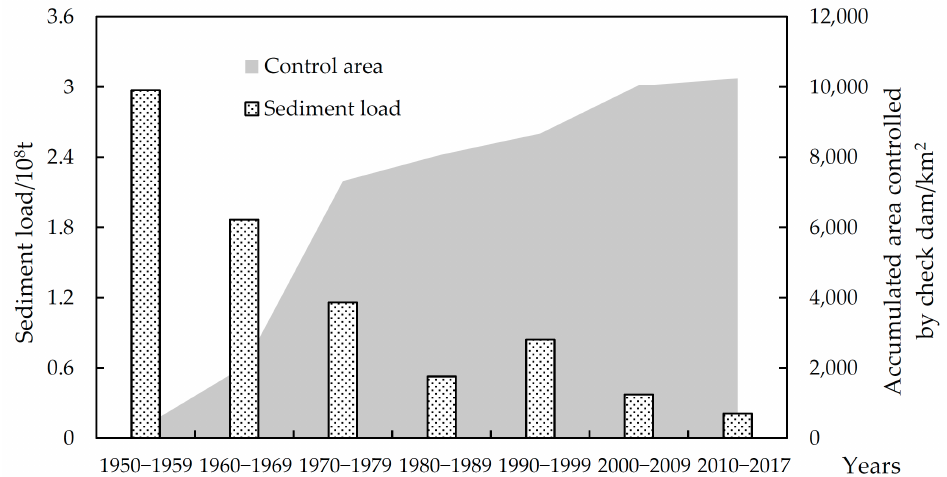
Figure 7. Sediment load at the Baijiachuan gauging station, and the cumulative control area of main and medium-sized check dams in the Wuding River basin. and medium-sized check dams in the Wuding River